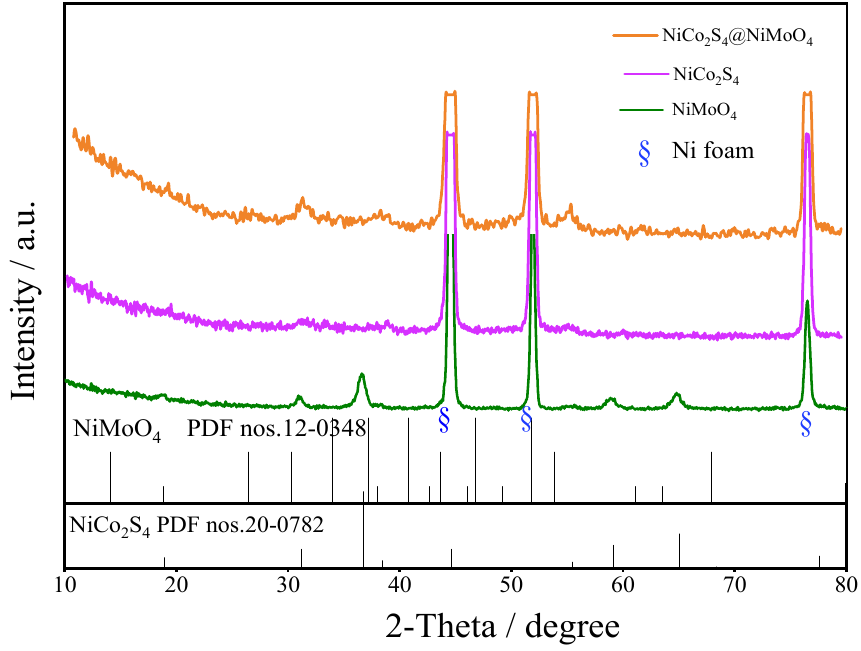
Figure 1. Structure characterization for XRD pattern of the samples.